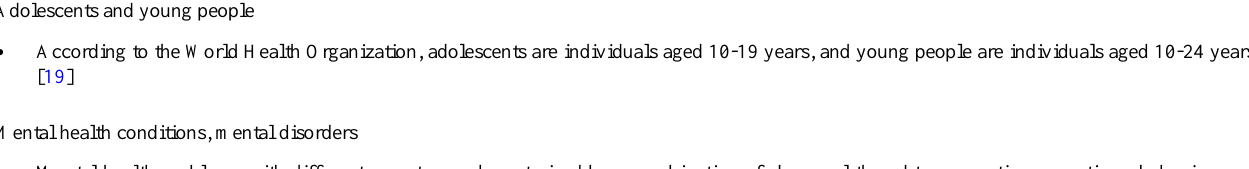
Textbox 1. Definitions of key terms. Adolescents and young